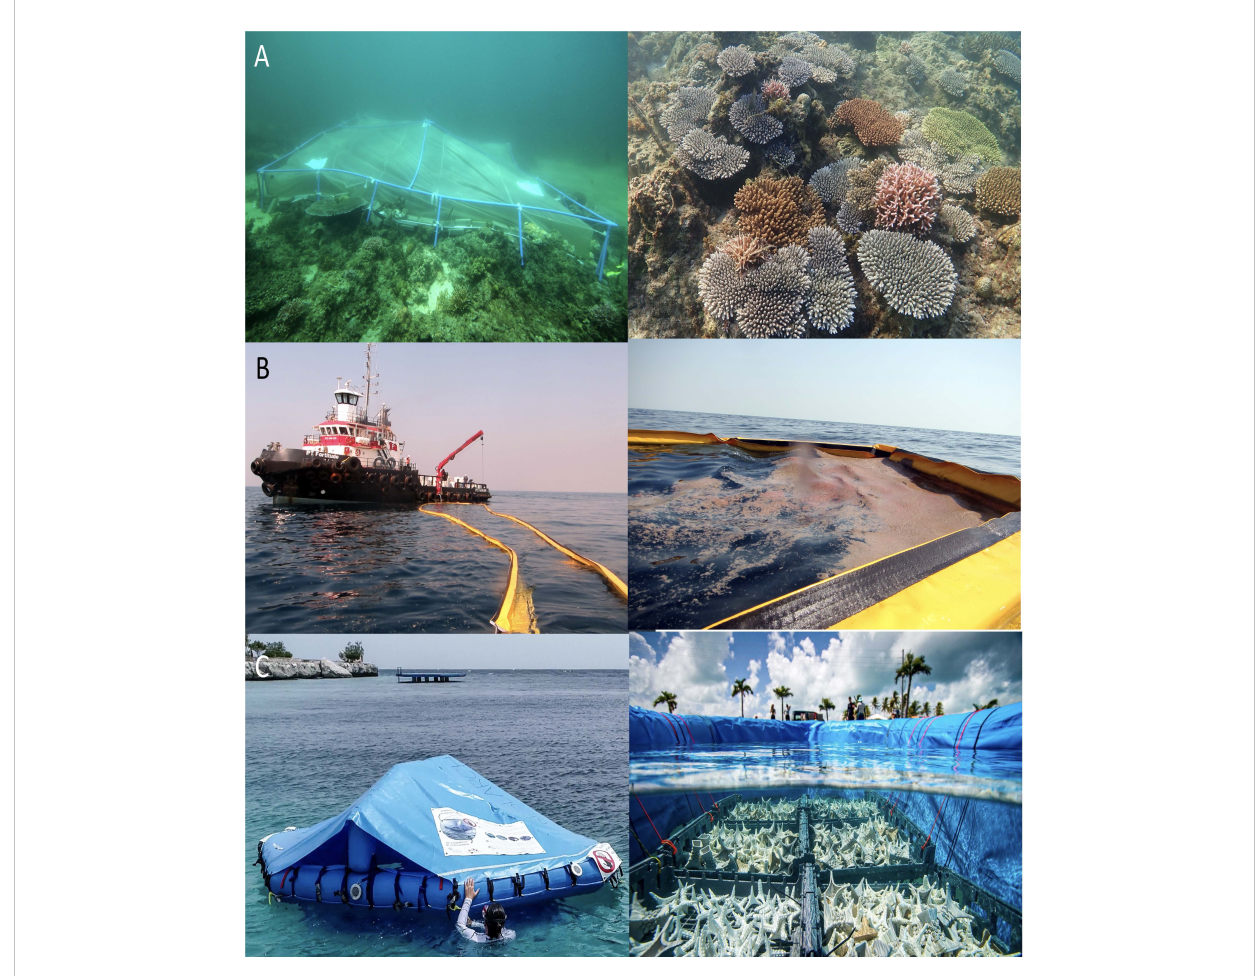
FIGURE 5 Aquaculture techniques that increase coral recruitment and eliminate nursery time. Row (A) Mesh enclosures effectively retain larvae and